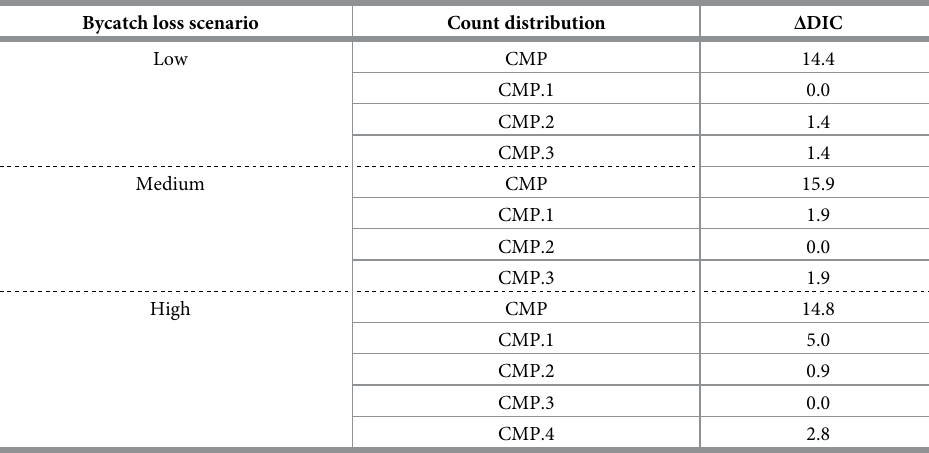
Candidate models under each bycatch loss scenario are identical except for the count distributions used for the positive catch. The count distribution CMP denotes the original Conway-Maxwell-Poisson distribution, and CMP [ k ], where k = 1,2 ... , denotes a modified Conway-Maxwell-Poisson distribution with the additional shape parameter k